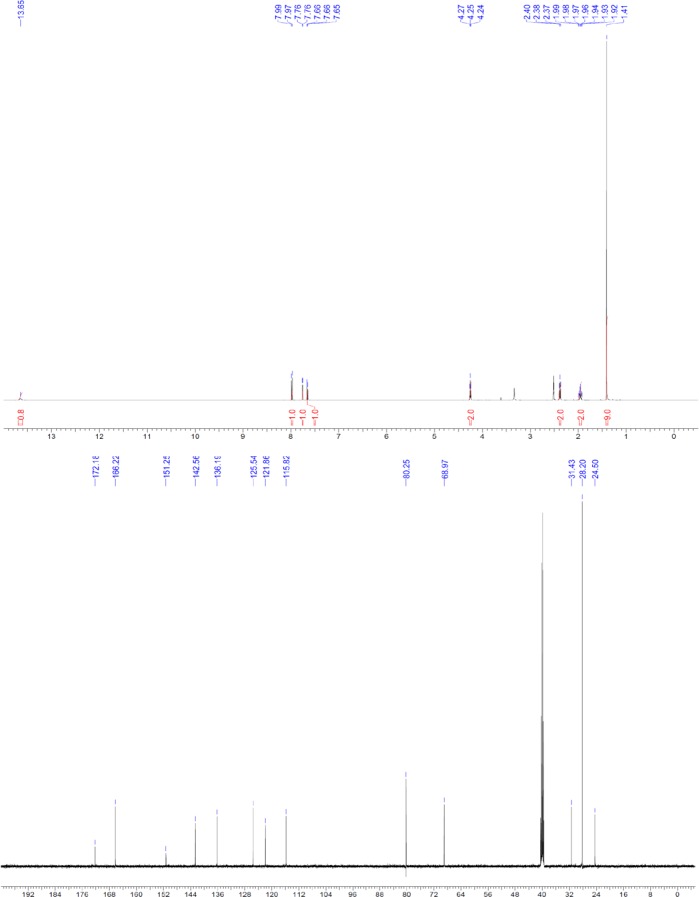
1H and 13C NMR of compound 3 f.